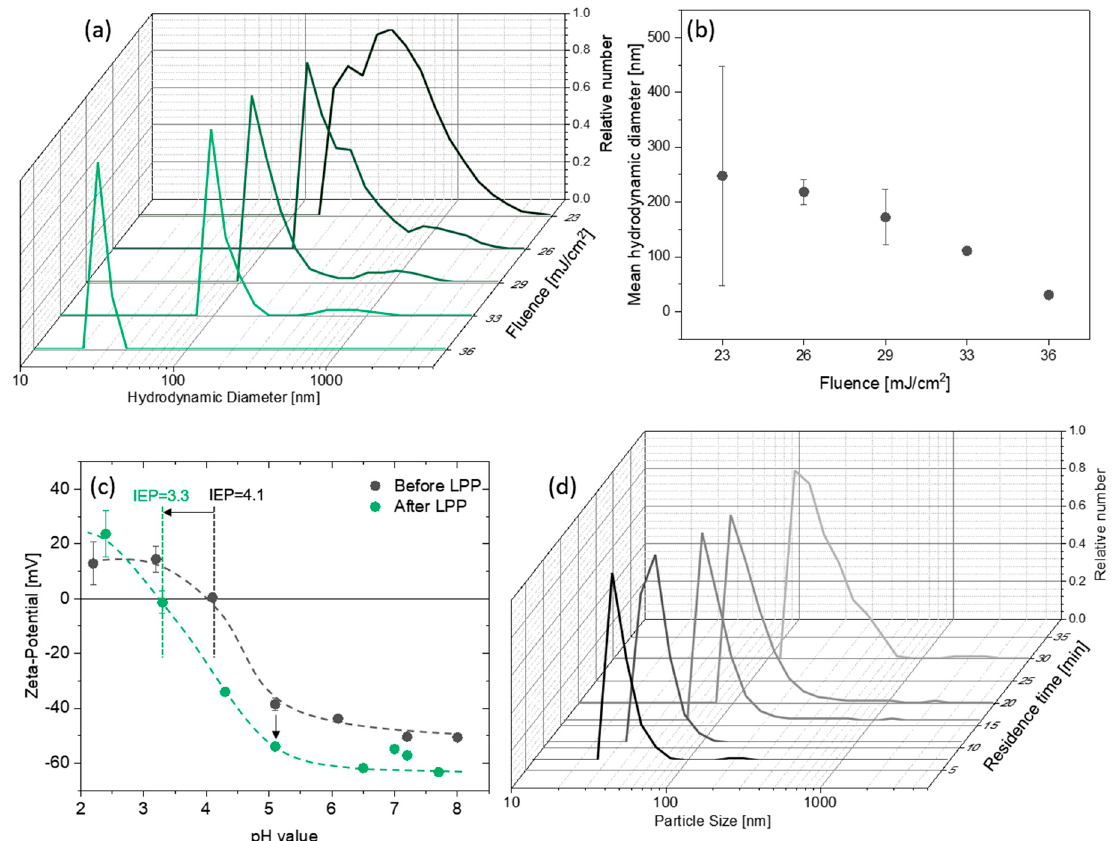
Figure 2. Laser postprocessing of carbon black with a high repetition rate laser system: ( a , b ) Hydrodynamic nanoparticle diameter (mass weighted) measured by dynamic light scattering (DLS) as a function of laser fluence. ( c ) Zeta potential as a function of the pH value of the dispersion before and after LPP. ( d ) Temporal evolution of the hydrodynamic particle size after laser irradiation. The error bars in panels ( b , c ) represent the standard deviation and are based on at least 3 samples each.